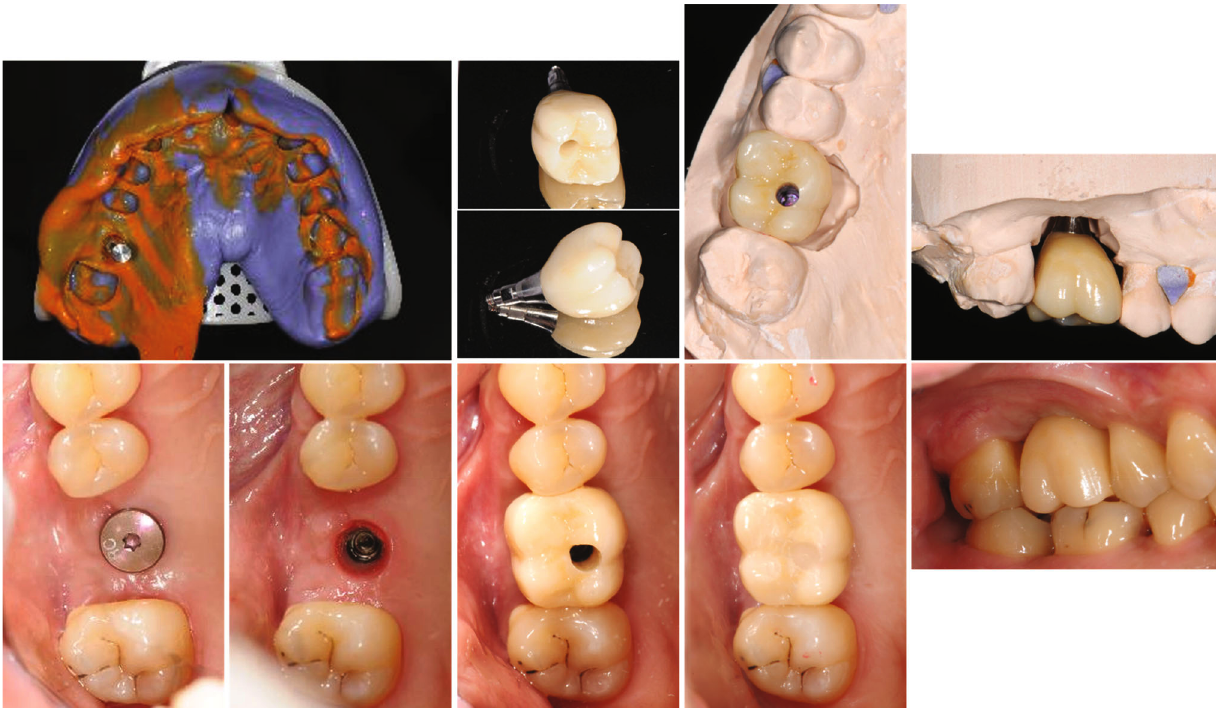
Figure 7: The process of delivering the